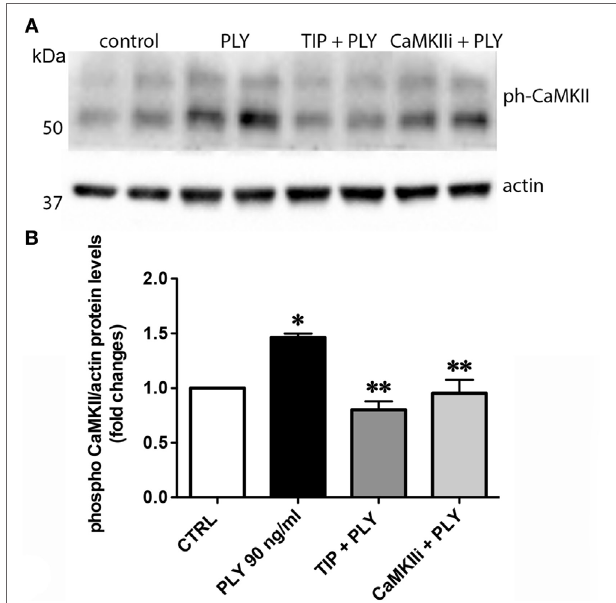
FigUre 4 | (a) Representative western blot and (B) quantification of phospho-CaMKII over actin ratio of PLY (90 ng/ml)-mediated CaMKII activation in human lung microvascular endothelial cells after 20 min. Cells were either pretreated with TIP peptide (50 µg/ml) or the CaMKII inhibitor XII (1 mM) for 15 min. Values are presented as means ± SD of three independent experiments in duplicates (* p < 0.05 versus ctrl, ** p < 0.05 versus PLY).